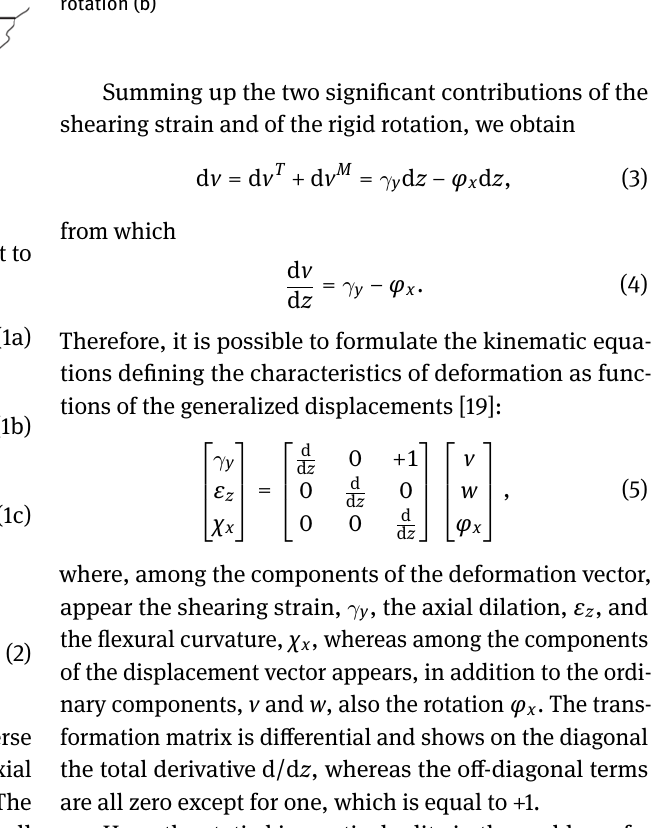
Figure 4: Beam with rectilinear axis: Relative transverse displace- ments in a rectilinear beam due to shearing strain (a) and rigid rotation